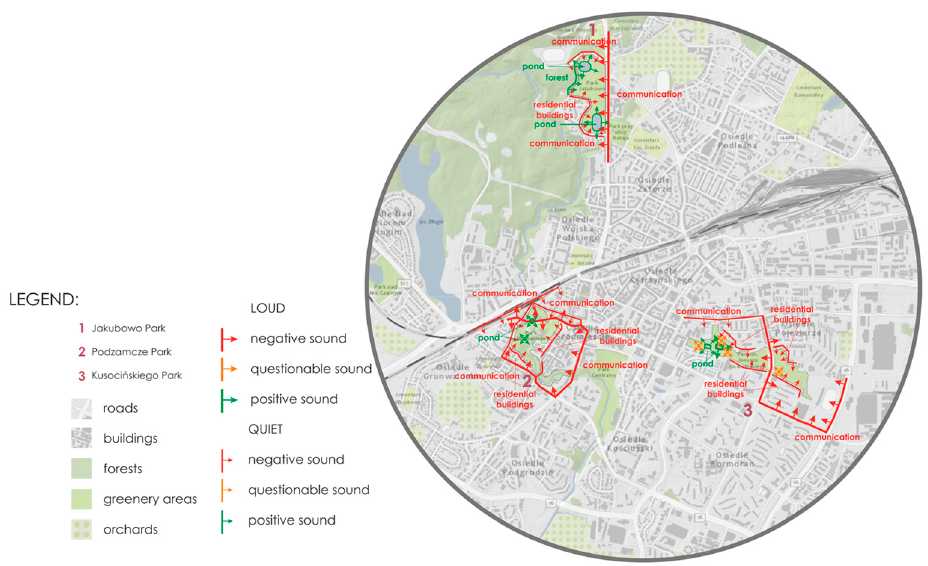
Figure 3. Location of the analyzed parks in the city center, and spatial analysis of the park surround- ings in relation to noise sources.